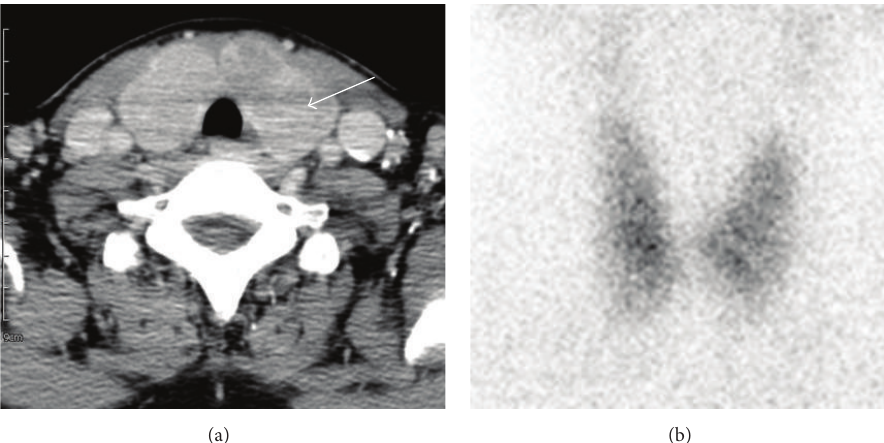
Figure 3: (a) Neck computed tomography shows 1.9 × 1.2 cm sized hypodense mass involving thyroid isthmus in the left thyroid. (b) Thyroid scan with Tc- 99 m pertechnetate shows diffuse and even uptake in both thyroid